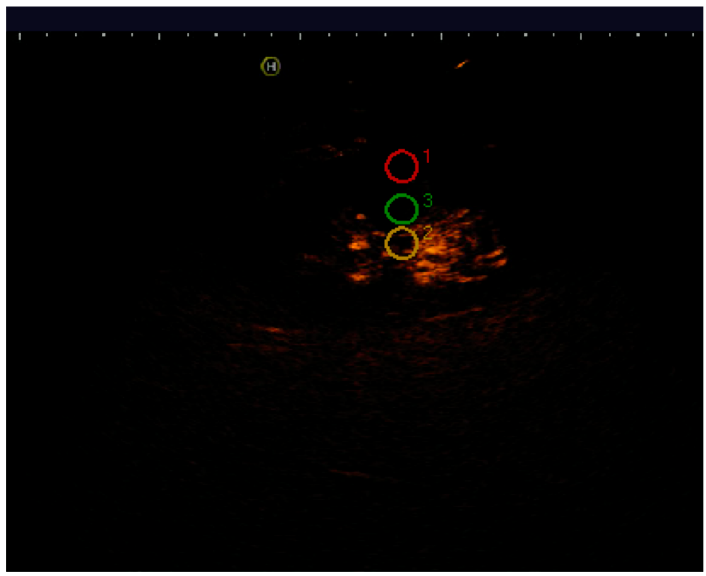
Figure 1. Placement of the three circular regions of interest (ROIs) in medullary region, interlobar arteries, and subcapsular cortex for the analysis of intensity curves (TIC).